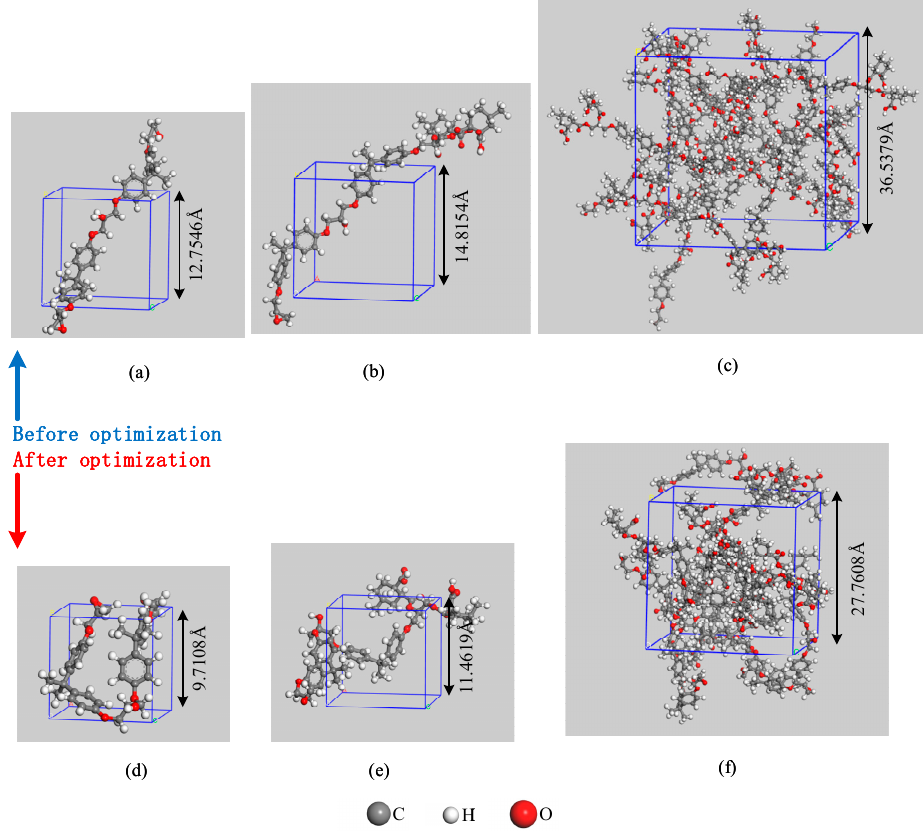
Figure 2. Structures of the three models. Structures before optimization of ( a ) Model 1, ( b ) Model 2, and ( c ) Model 3; Structures after optimization of ( d ) Model 1, ( e ) Model 2, and ( f ) Model 3.